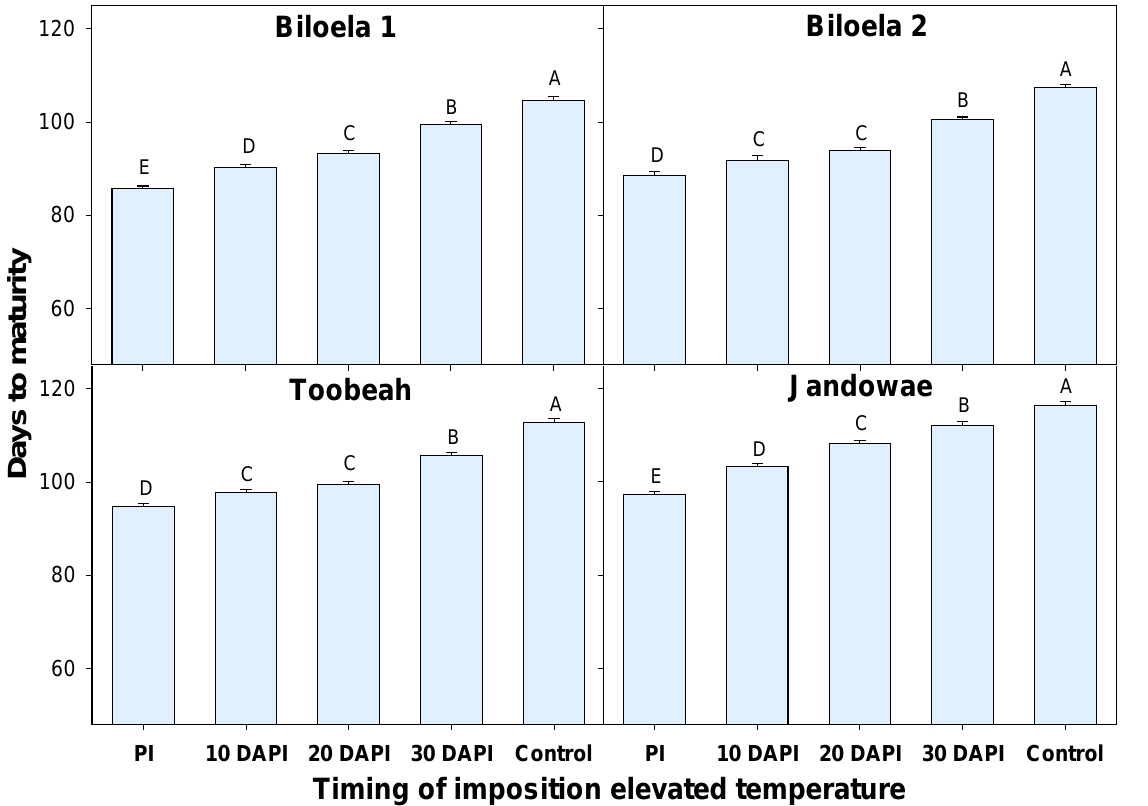
Figure 1. Effect of elevated temperature applied at panicle initiation (PI), 10 days after panicle initi- ation (10 DAPI), 20 DAPI or 30 DAPI, on plant maturity time of four Avena sterilis ssp. ludoviciana